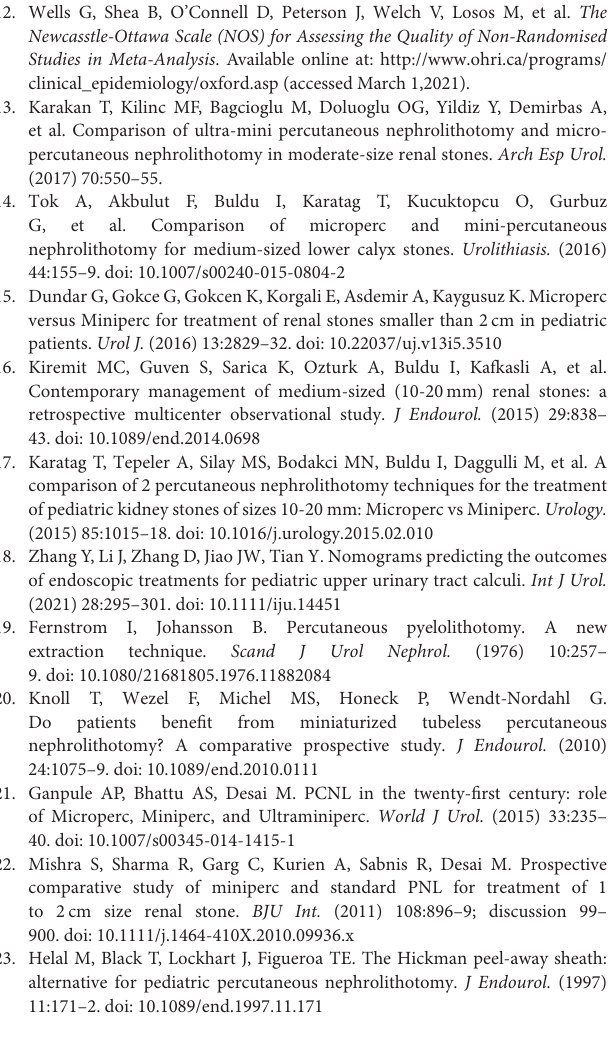
Supplementary Figure 1 | Funnel plot evaluating the publication